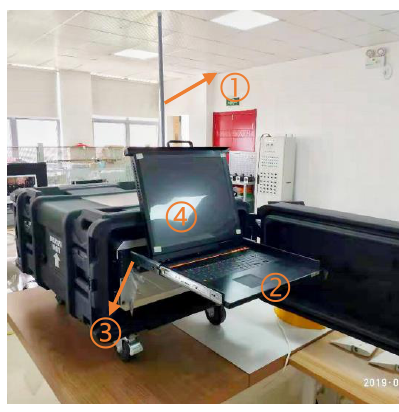
Figure 2. Layout of the xAUV.